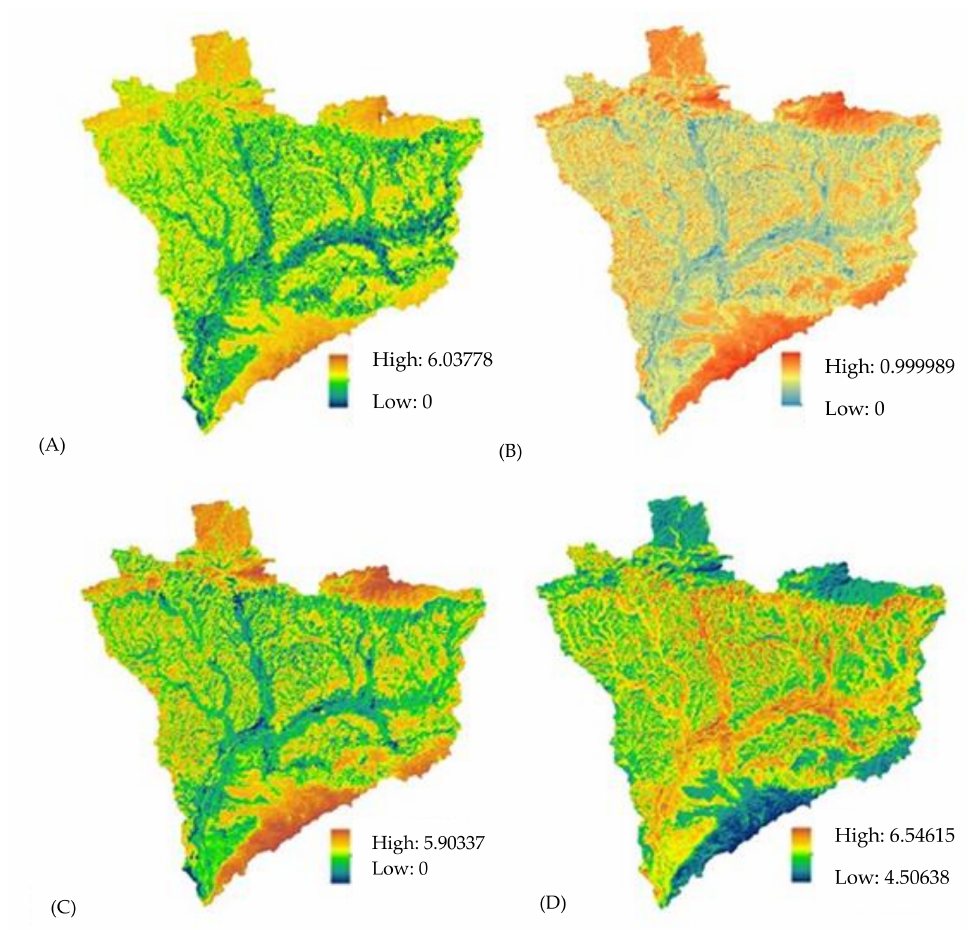
Figure 5. Spatial distribution (6th June 2000) of ( A ) SEBAL ET [mm day − 1 ]; ( B ) Λ INT [1]; ( C ) ET based on proposed concept [mm day − 1 ]; ( D ) PET (Penman–Monteith) [mm day − 1